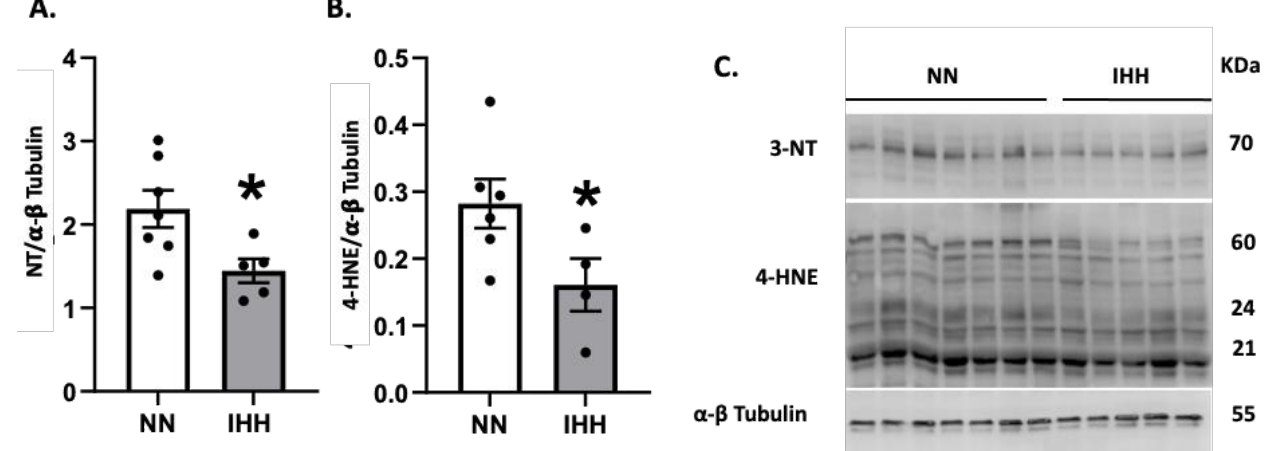
Figure 6. Cardiac oxidative stress. Quantification of cardiac protein levels of 3-Nitrotyrosine (3-NT) ( A ) and 4-hydroxynonenal (4-HNE) ( B ) as oxidative stress markers. Western blot bands are shown ( C ). Groups are normobaric normoxia (NN, n = 6) and intermittent hypobaric hypoxia (IHH, n = 6). Data are expressed in mean ± SEM. Significant differences ( p ≤ 0.05): * vs. N N.